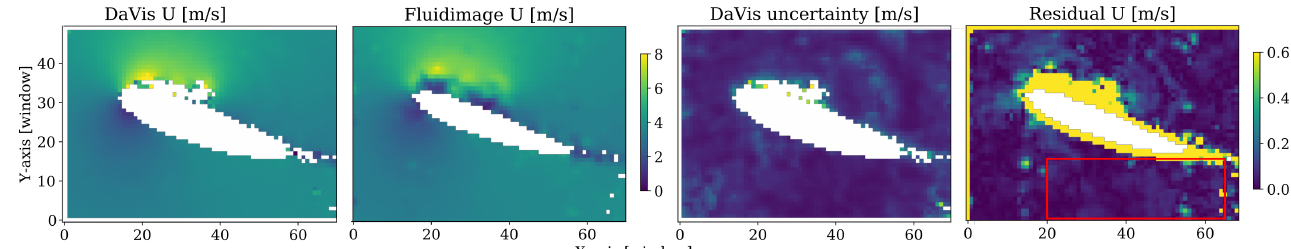
Figure 7. ( Far left ) Velocity field in m/s obtained by DaVis; ( center left ) Resulting field from Fluidimage with temporal rolling average with window size 4 and a Gaussian smoothing; ( center right ) Uncertainty of the PIV measurement in m/s from DaVis; ( far right ) difference between the magnitudes of the velocities from DaVis and Fluidimage, in